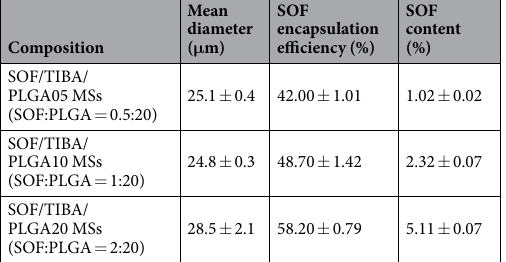
Table 1. Characterization of SOF/TIBA/PLGA MSs. The ratio between SOF and PLGA is presented as the input amounts of materials. Data are presented as mean ± standard deviation (SD) ( n = 3). Ε = × ncapsulation efficiency(%) 100 actual amount of SOF in MSs . input amount of SOF in MSs = × Drug content(%) 100 actual amount of SOF in MSs − amount of SOF loaded MSs